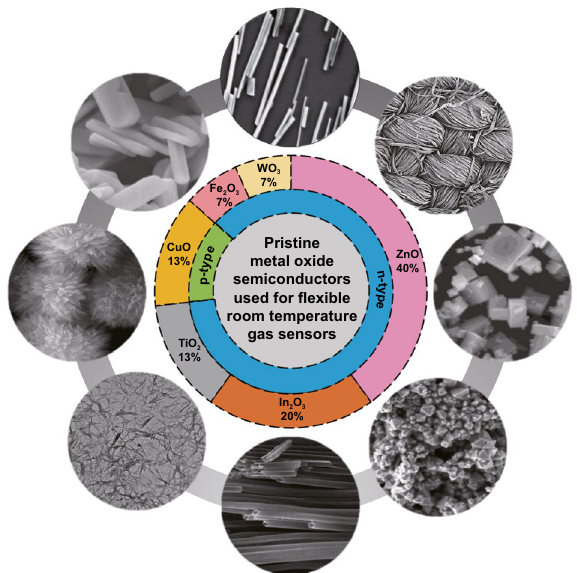
Fig. 2 Schematic diagram of various pristine metal oxide semicon‑ ductor used for flexible room‑temperature gas sensors introduced in this